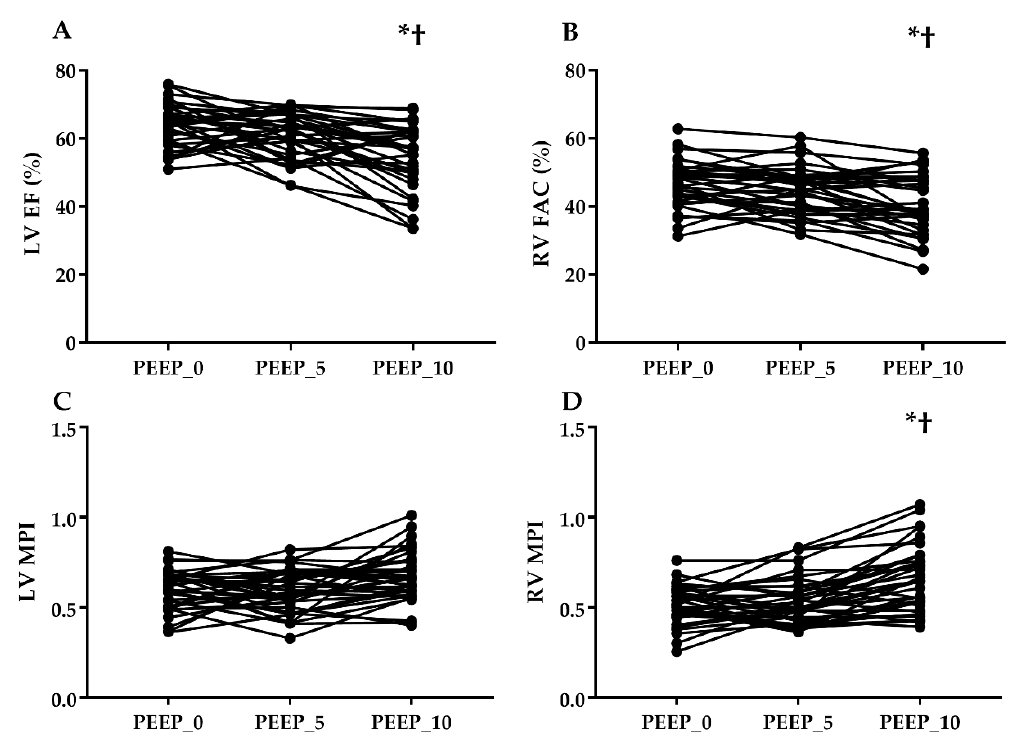
Figure 4. E ff ects of positive end-expiratory pressure on the changes of cardiac function. ( A ) LV EF, left ventricular ejection fraction; ( B ) RV FAC, right ventricular fractional area change; ( C ) LV MPI, left ventricular myocardial performance index; ( D ) RV MPI, right ventricular myocardial performance index. * p < 0.05 versus PEEP_0, † p < 0.05 versus PEEP_5.